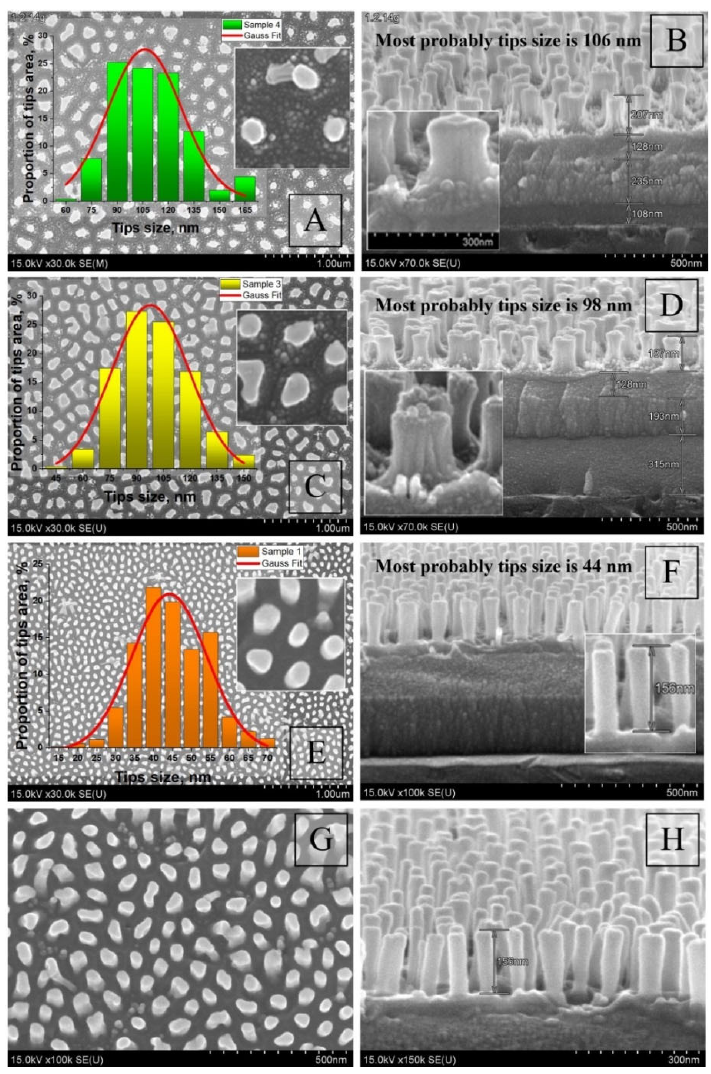
Figure 5. Surface and cross ‐ section SEM images and size histograms for the Ta 2 O 5 pillars after the Al 2 O 3 selective etching: ( A , B )—sample 4 of type II; ( C , D )—sample 3 of type II; ( E – H )—sample 1 of type I.